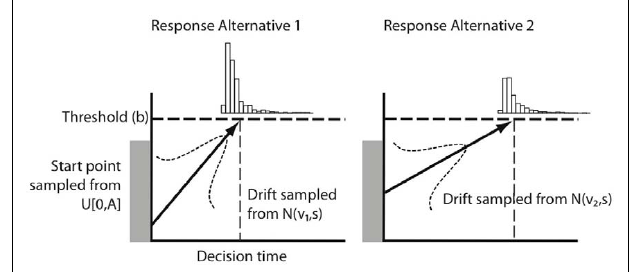
FIGURE 2 | LBA model. The accumulator representing response alternative 1 is on average faster than the competing accumulator.The model therefore predicts that response alternative 1 will be selected on the majority of trials. See text for details.